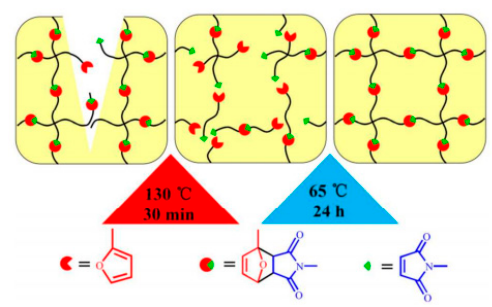
Figure 4. Schematic illustration of the self-healing mechanism of WPU-DA-x [36].